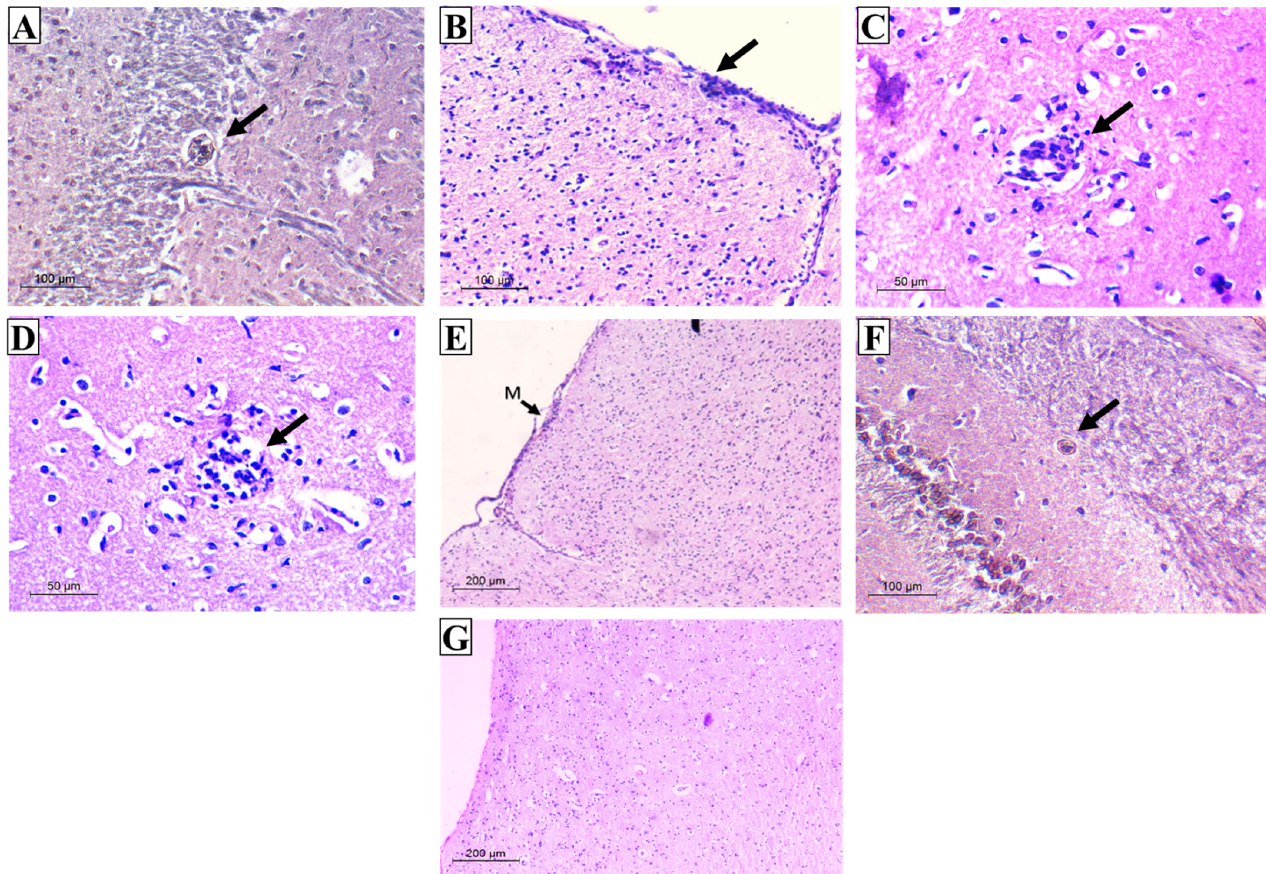
Figure 9. Histopathological outcomes in the examined brain sections of the infected control group ( A – E ) and vaccinated groups ( F , G ). ( A ) GMS section displaying rounded T. gondii cyst with well-defined intact wall in the cerebellum (×200); ( B ) H&E section displaying severe meningitis on cerebral cortex surface (×200); ( C ) H&E section displaying perivascular infiltration (×400); ( D ) H&E section displaying aggregates of microglial cells (×400); ( E ) H&E section displaying hypercellularity all over the brain tissue (M: meninges) (×100); ( F ) GMS section displaying very small cyst with thin wall and few bradyzoites (×200); ( G ) H&E section displaying the upgrading of inflammatory scores with the absence of either meningeal infiltration or cerebral-increased cellularity (×100).